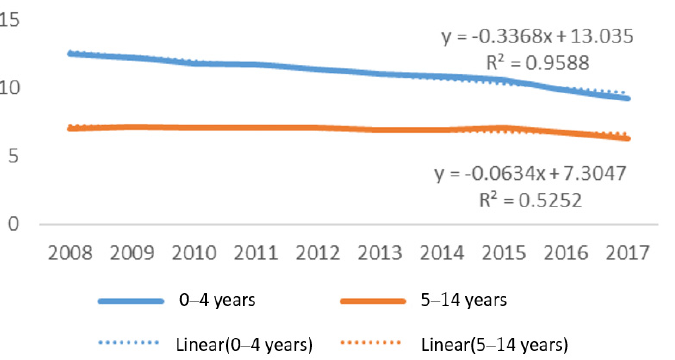
Figure 4. Trends over time in rate of fatal drowning per 100,000 population, 0–4 years and 5–14 years age groups, Philippines, 2008–2017.